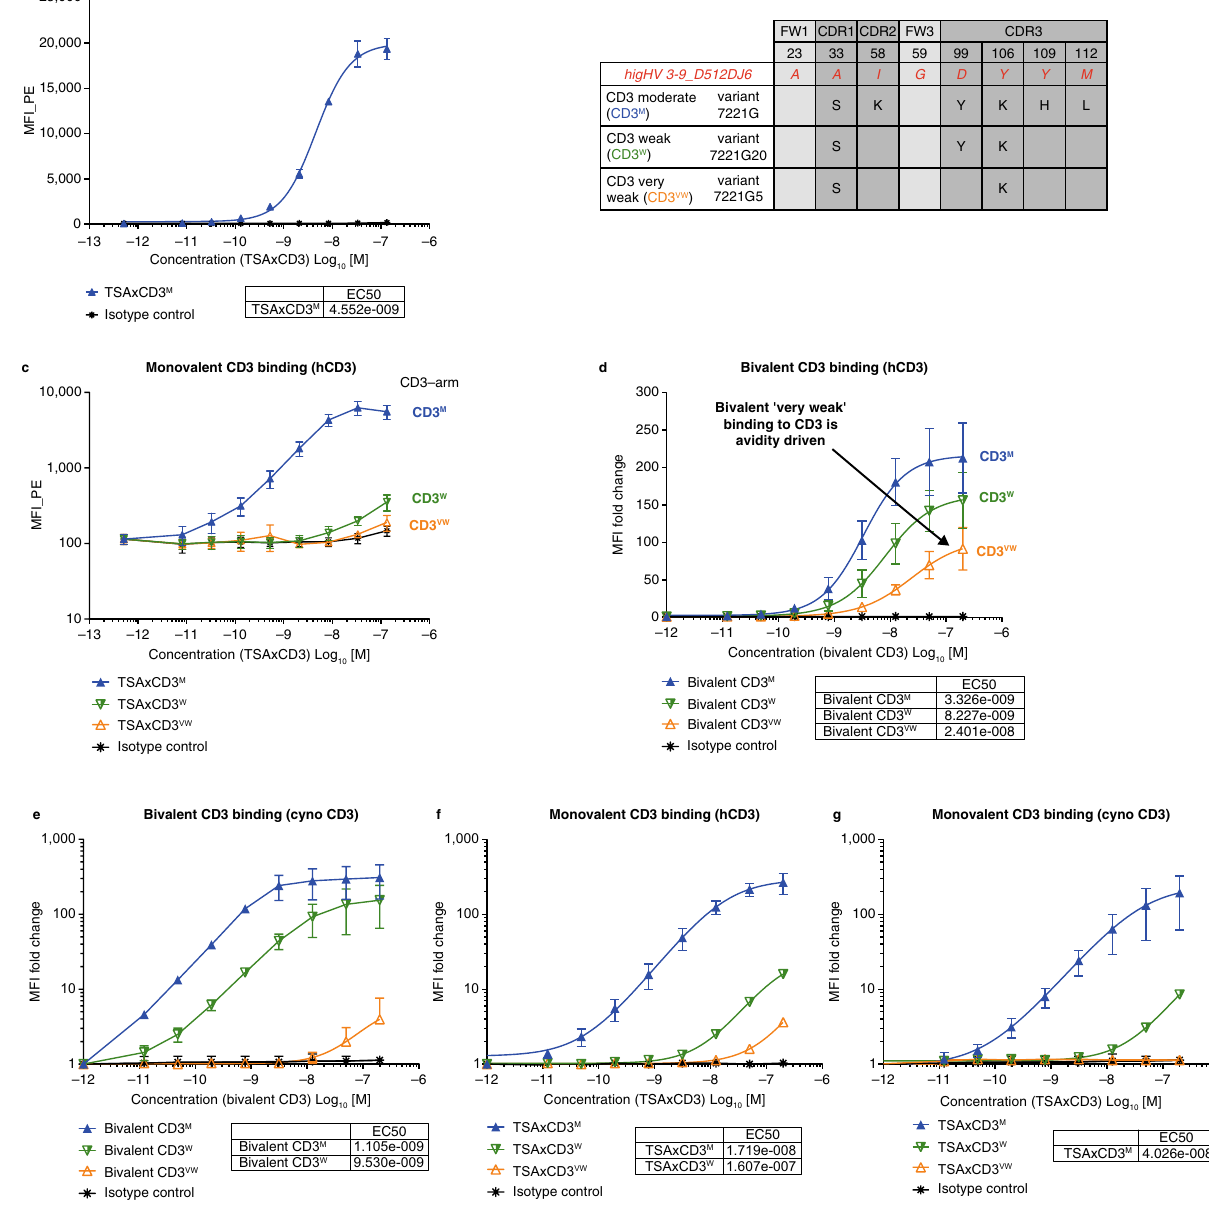
Figure 1. Generation of a CD3-arm de-affinity maturation library from VelocImmune mice-derived antibodies yields variants with reduced affinity for CD3. ( a ) Binding of anti-CD3 antibodies isolated from VelocImmune mice to Jurkat cells by flow cytometry; ( b ) summary of CD3 variant generated using germlining approach; ( c ) binding of CD3 variants to Jurkat cells by flow cytometry; ( d ) binding of selected parental CD3 variants to human T cells by flow cytometry; ( e ) binding of selected parental CD3 variants to cynomolgus T cells by flow cytometry; ( f ) binding of selected variants reformatted as TSAxCD3 bispecific antibodies on human T cells by flow cytometry; ( g ) binding of selected variants reformatted as TSAxCD3 bispecific antibodies on cynomolgus T cells by flow cytometry (three replicates). CDR complementary determining region; EC50 half maximal effective concentration; FW framework region; hCD3 human CD3; m moderate; MFI median fluorescent intensity; TSA tumor-cell-specific-antigen; vw very weak; w